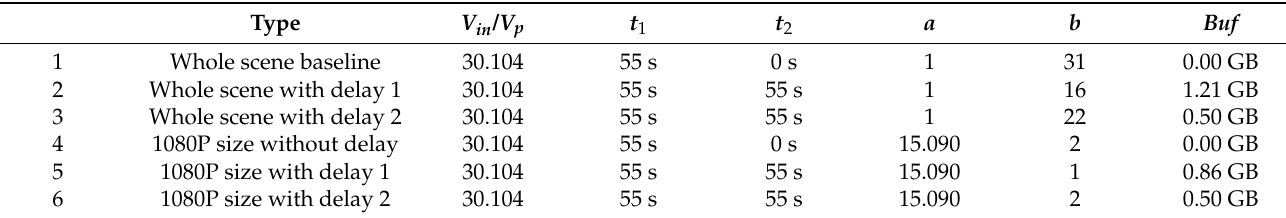
Table 3. Analysis of the stream computing balance